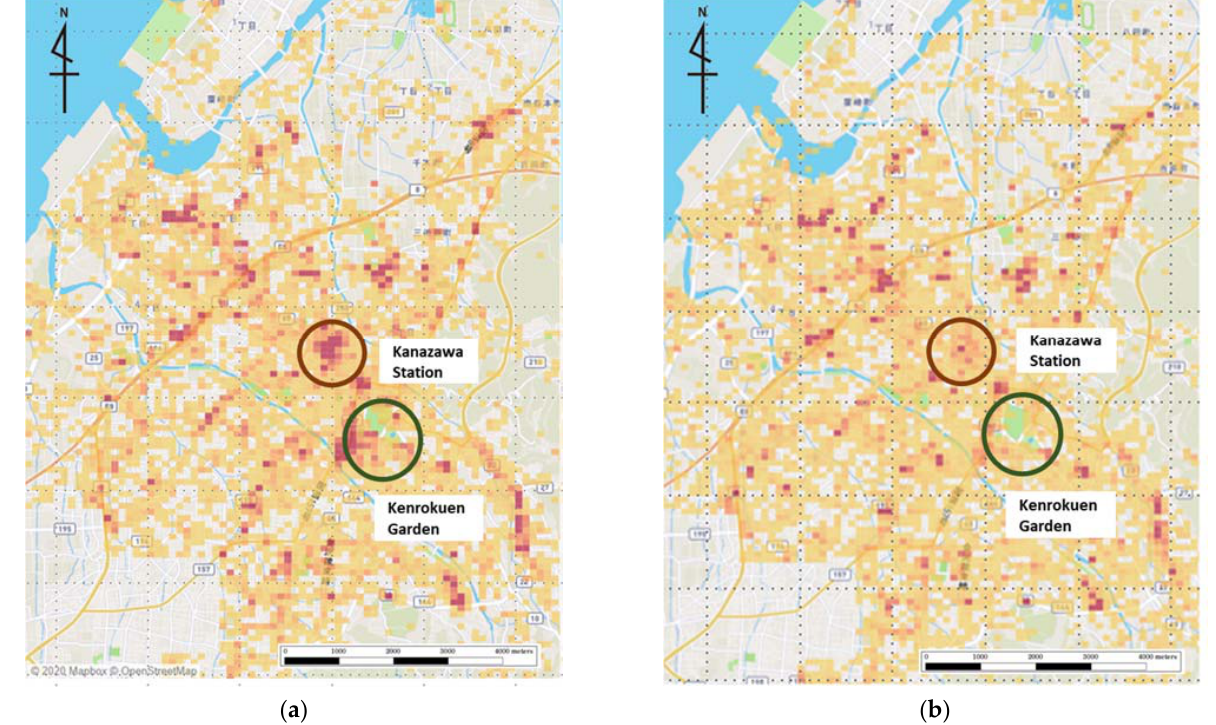
Figure 2. ( a ) ( left ) and ( b ) ( right ) ( a ) Movement of people on holidays in 2019. The darker the color, the more people were concentrated in the area. ( b ) Movement of people on holidays in 2020. The darker the color, the more people were concentrated in the area.